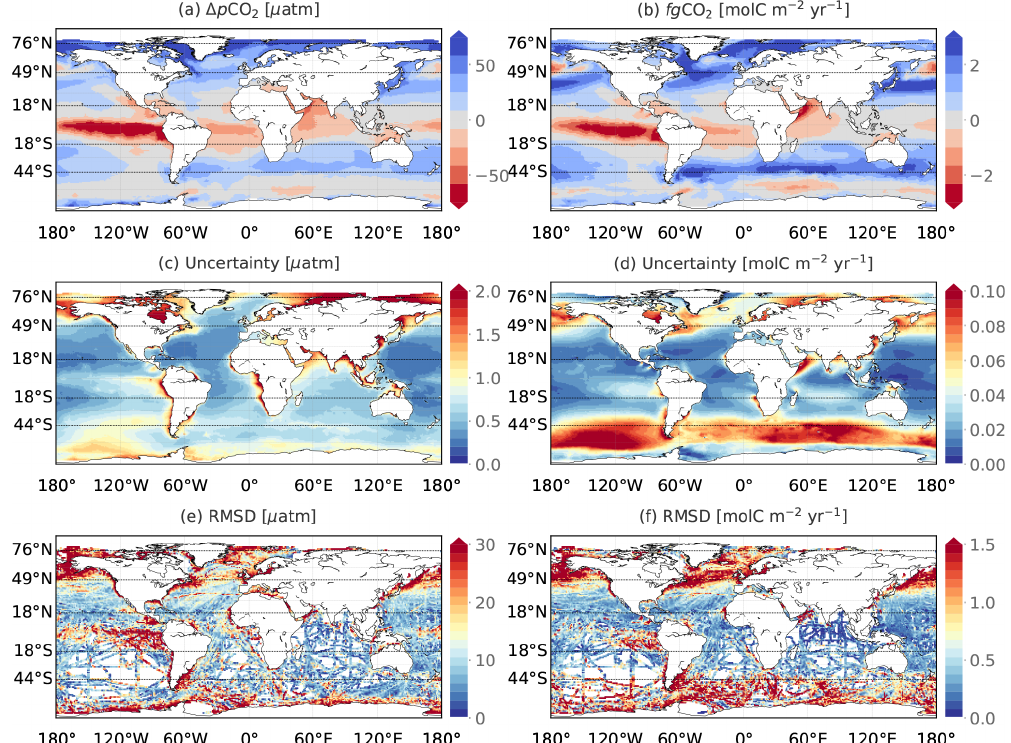
Figure 5. Climatological mean (a, b) and uncertainty (c, d) of air–sea p CO 2 difference (a, c) and of CO 2 fluxes (b, d) over 1985–2019. Uncertainty (Eq. 2) is computed as the standard deviation of the 100-member CMEMS-LSCE-FFNN model outputs of sea surface p CO 2 and air–sea CO 2 fluxes. The bottom panels (e, f) show RMSDs (Eq. 4) between the SOCAT data (or data-based estimates of fluxes for f ) and the mean CMEMS-LSCE-FFNN model outputs.